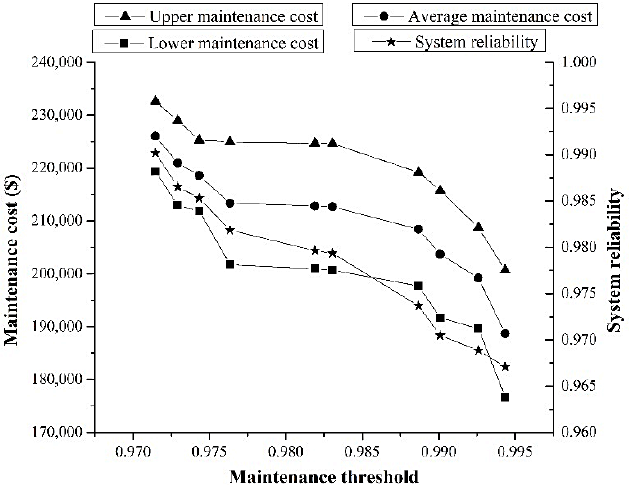
Figure 4. Maintenance cost and system reliability as a function of maintenance threshold.